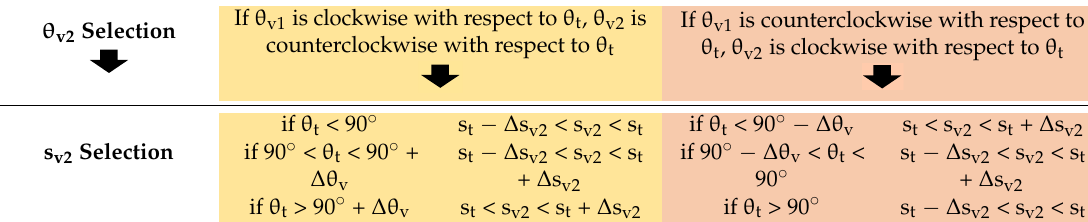
Table 1. Search logic for the second narrow-V wake.